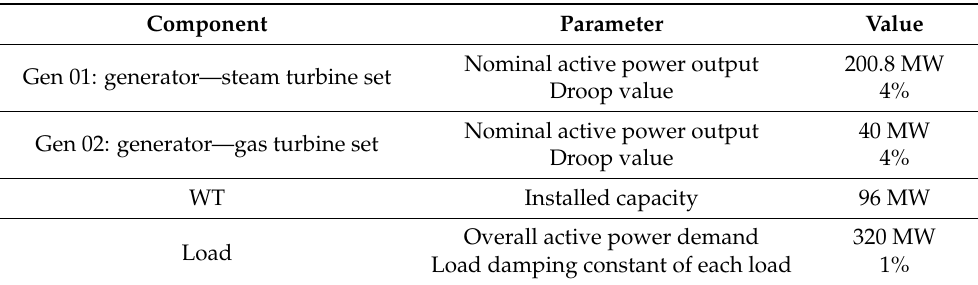
Table A1. System